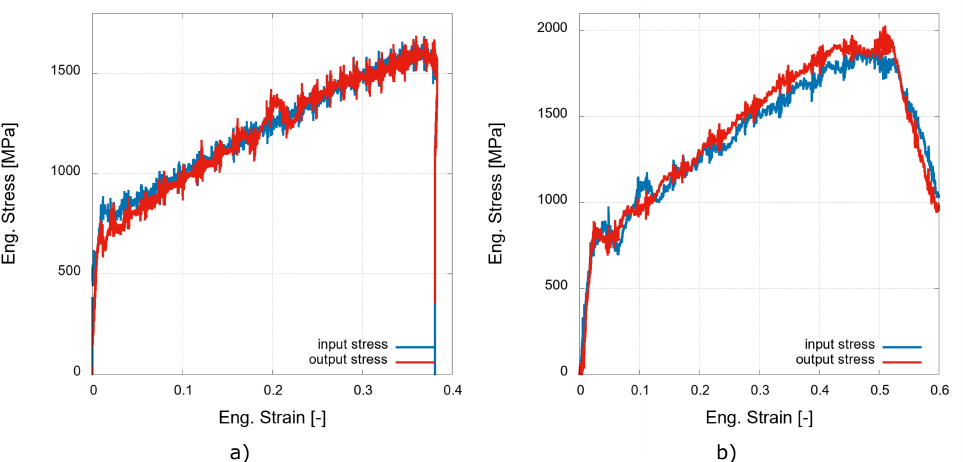
Figure 8. Representative examples of the dynamic stresses equilibrium achieved during ( a ) low-rate and ( b ) high-rate experiments.